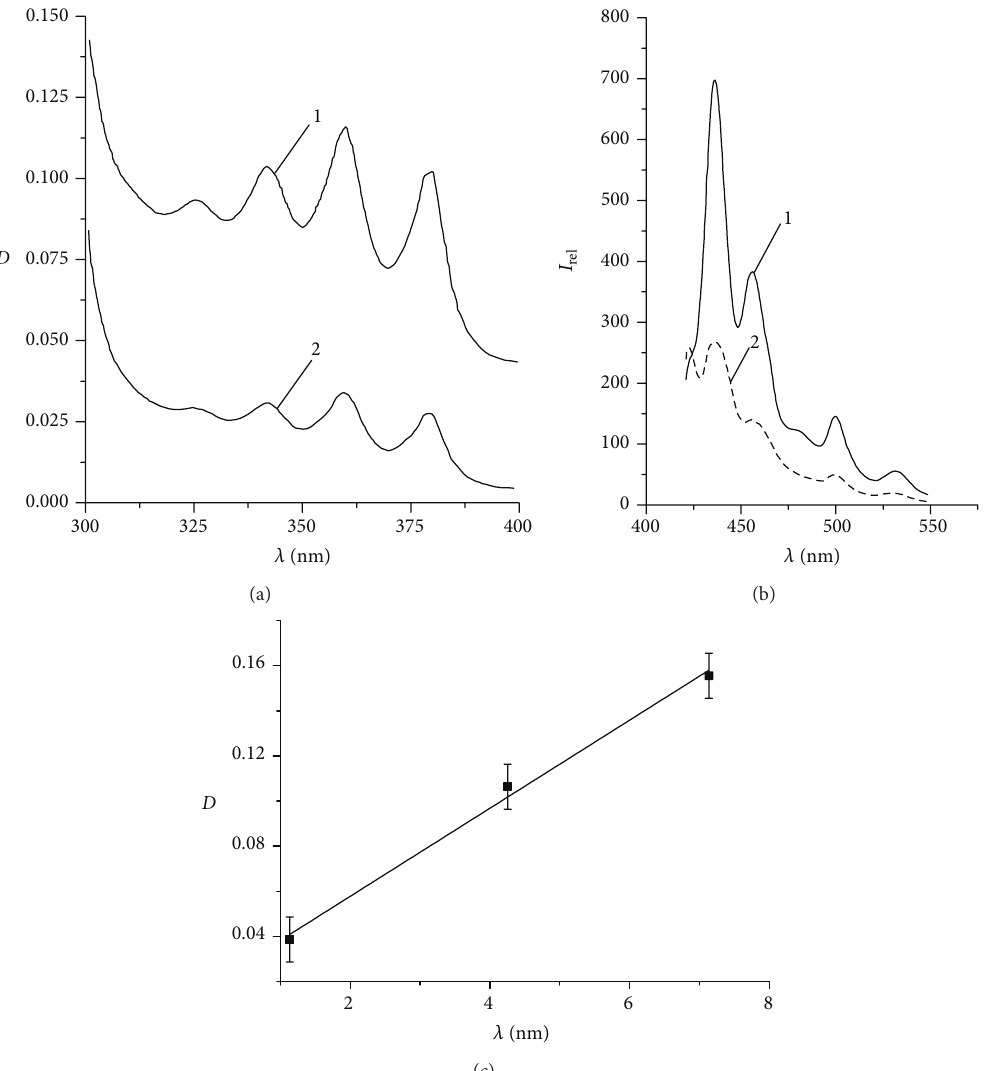
Figure 1: Spectra of (a) absorption and (b) fluorescence of anthracene in HSA (pH 7.4). Curves 1 and 2 correspond to HSA concentrations = 10 mg/mL and 𝐶 = 1 mg/mL, respectively. Wavelength of fluorescence excitation is 380nm. (c) The dependence of optical density 𝐶 HSA HSA of singlet-singlet absorption of anthracene ( 𝜆 = 360 nm) on anthracene concentration in HSA solution ( 𝐶